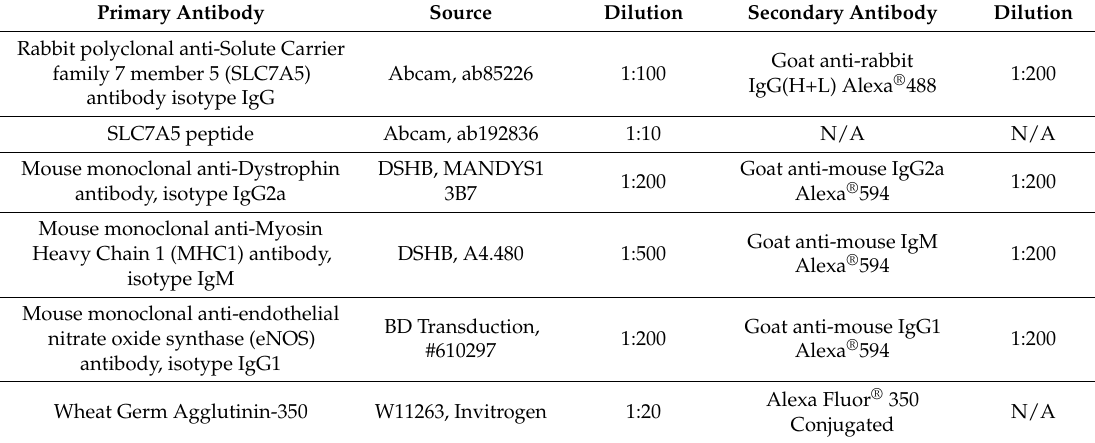
Table 1. Summary of antibodies